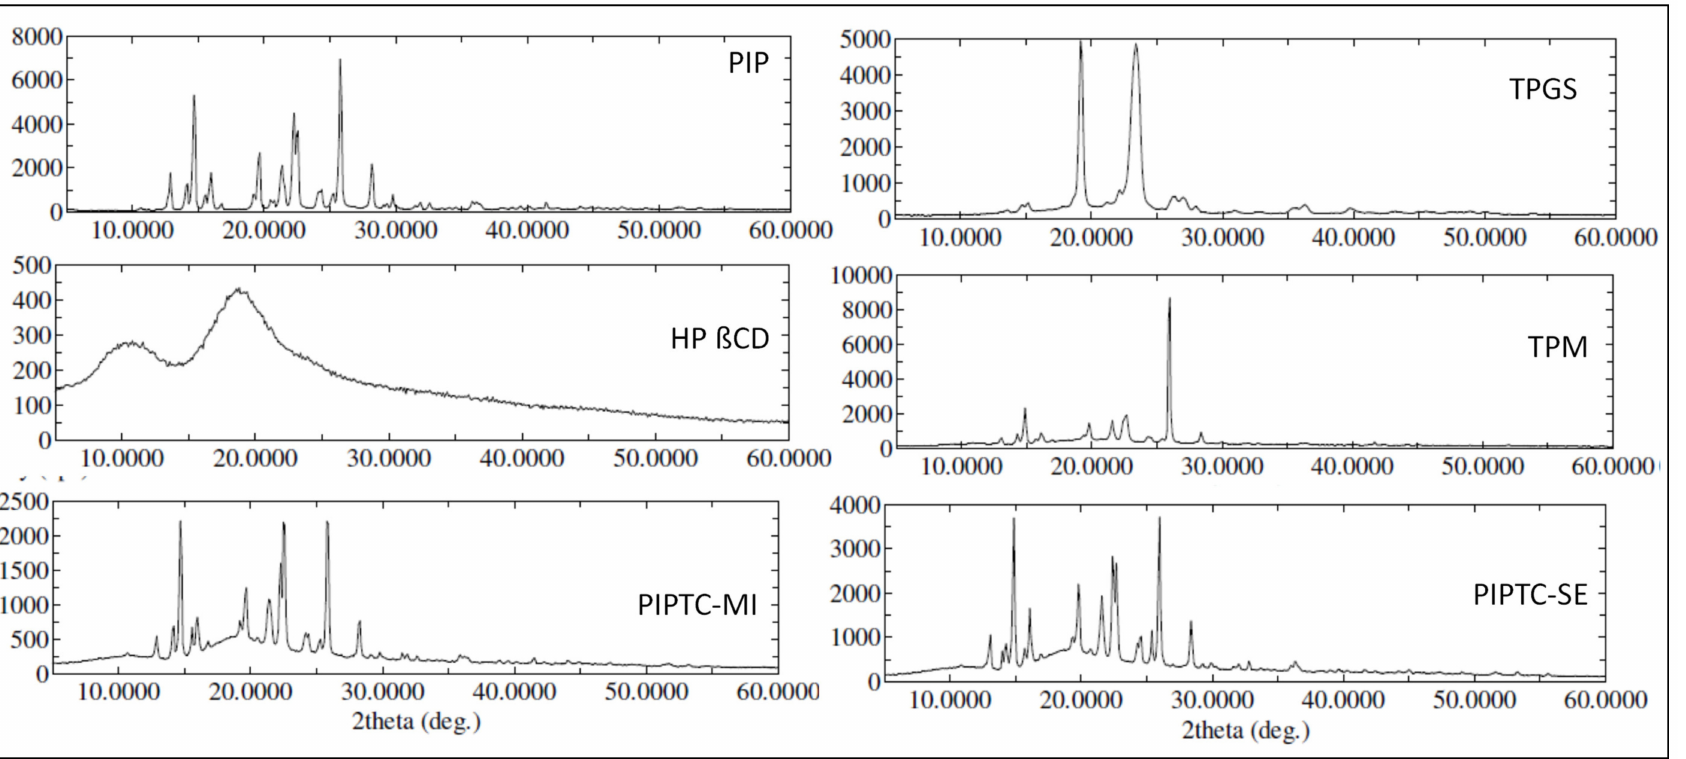
Figure 5. X-ray spectra of pure piperine, TPGS, HP β CD, PIP ternary physical mixture, piperine ternary inclusion complex (MI), and piperine ternary inclusion complex